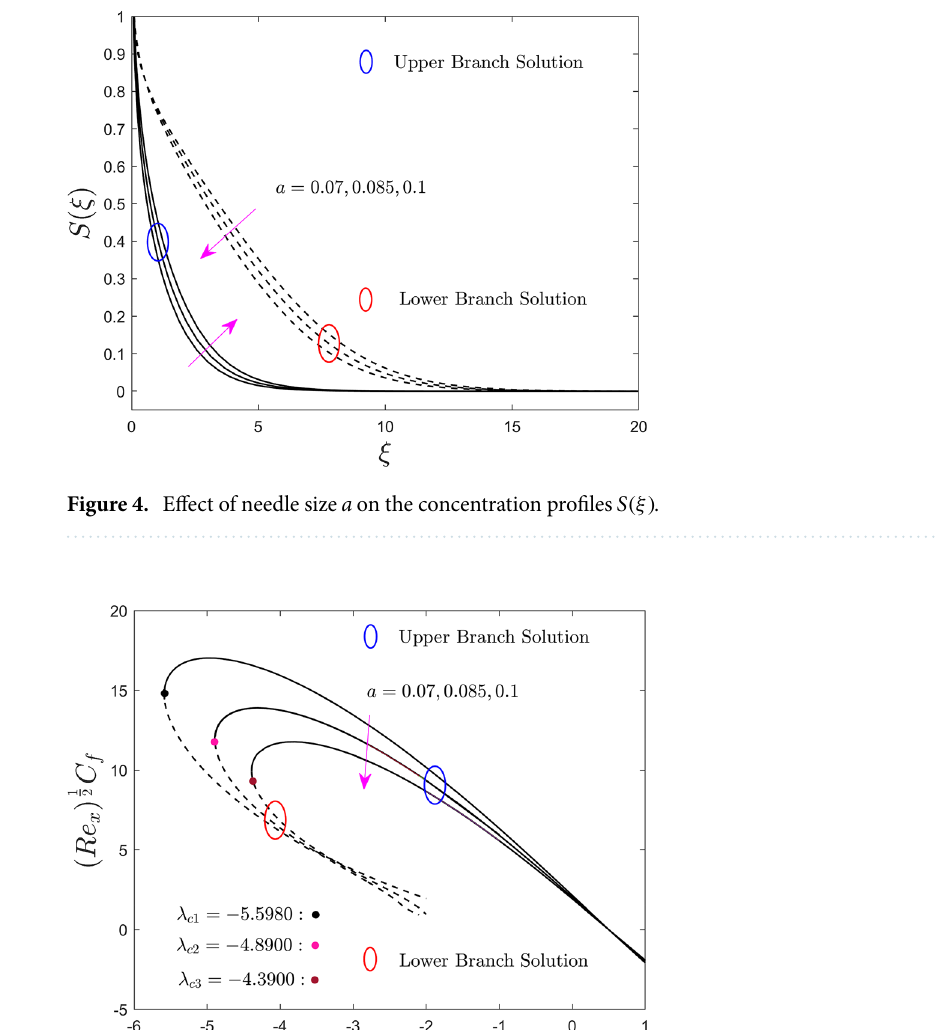
Figure 6. Effect of needle size a on the local Nusselt number ( Re x ) −